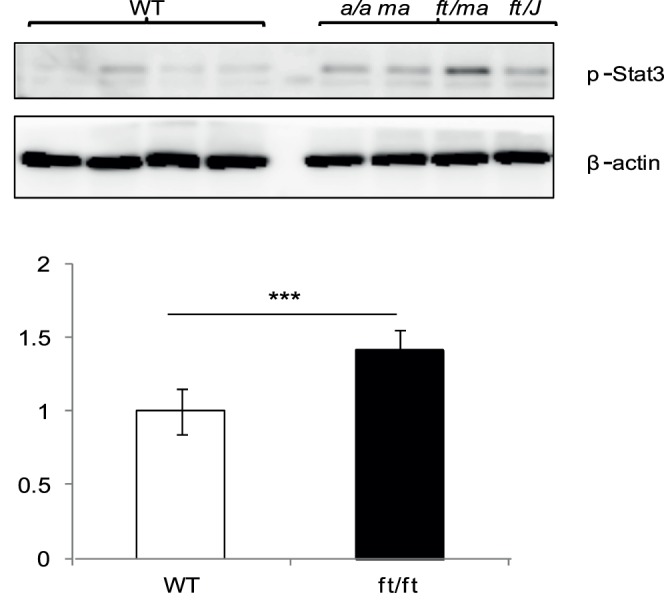
Stat3 phosphorylation in a/a ma ft/ma ft/J mouse epidermis.Protein skin extracts from P5 WT and a/a ma ft/ma ft/J (ft/ft) mice were submitted to WB, performed with rabbit anti-phospho-Stat3 and anti-actin antibodies, and detected by chemiluminescence. Quantification of p-Stat3 expression normalized to β-actin is represented in histograms. Statistical differences were calculated with the student T-test (***p<0.001).